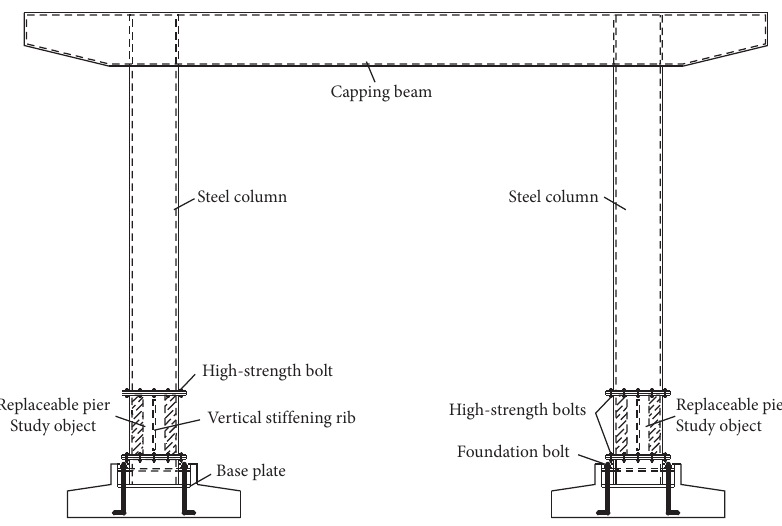
Figure 1: New type of portal steel bridge column with replaceable steel